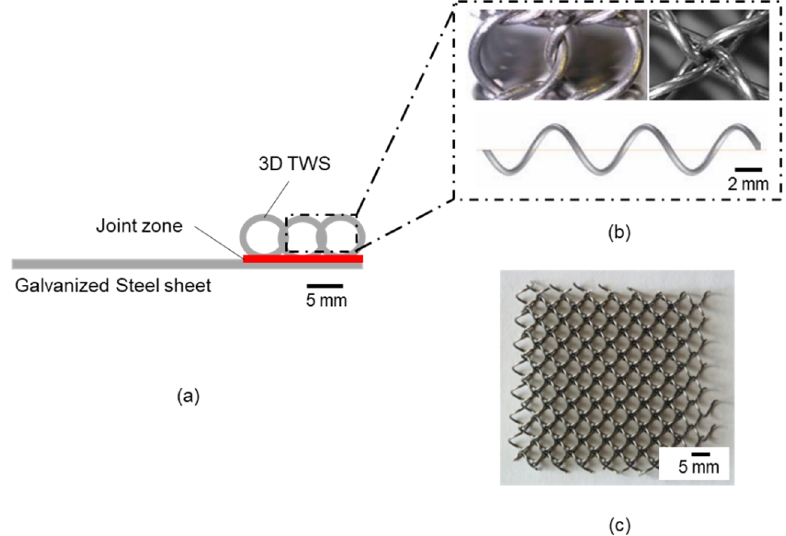
Figure 2. ( a ) Schematic setup of the brazed lap joint, ( b ) magnified view of 3D TWS strucwire ® , ( c ) top view of the 3D TWS with permeable regions visible.